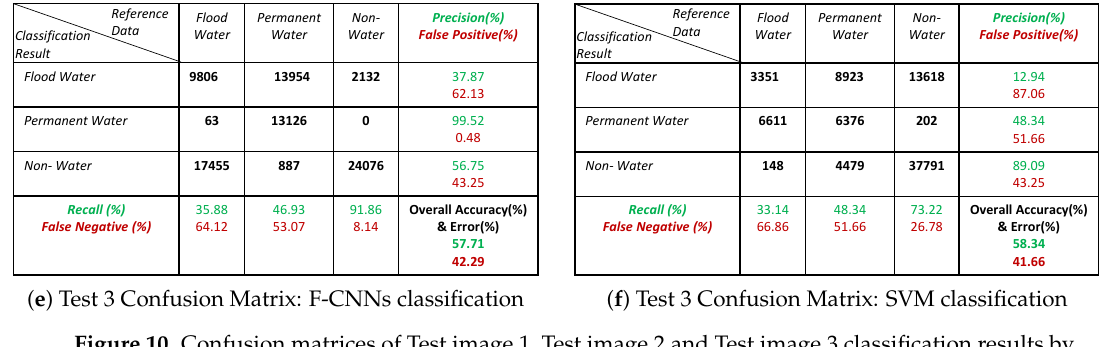
Figure 10. Confusion matrices of Test image 1, Test image 2 and Test image 3 classification results by F-CNNs and SVM: Confusion matrix listed the accuracy measures.